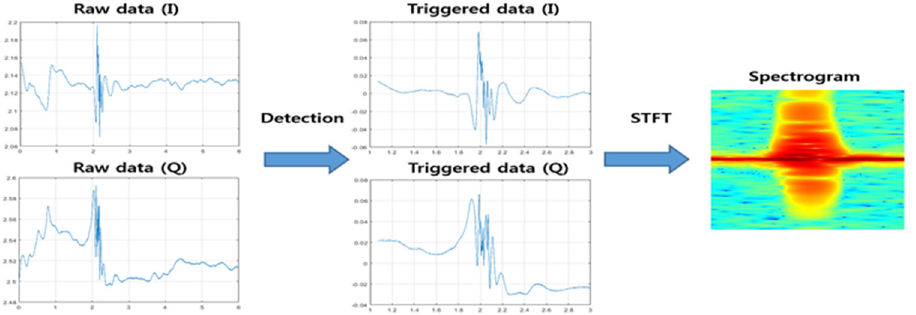
Figure 2. Example of detection.